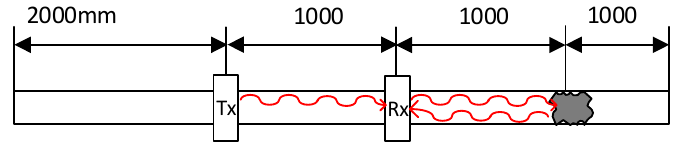
Figure 6. Location of the transmitter, receiver and blocking.